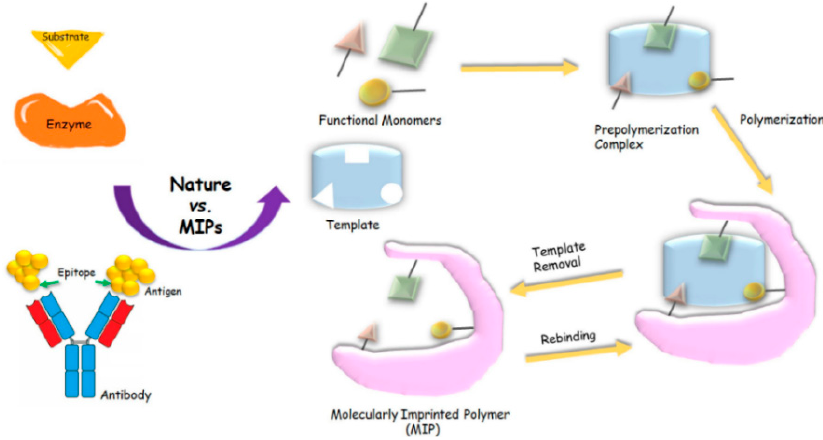
Figure 2. Workflow of MIP preparation Reprinted with permission from [20]. 2021, Elsevier.